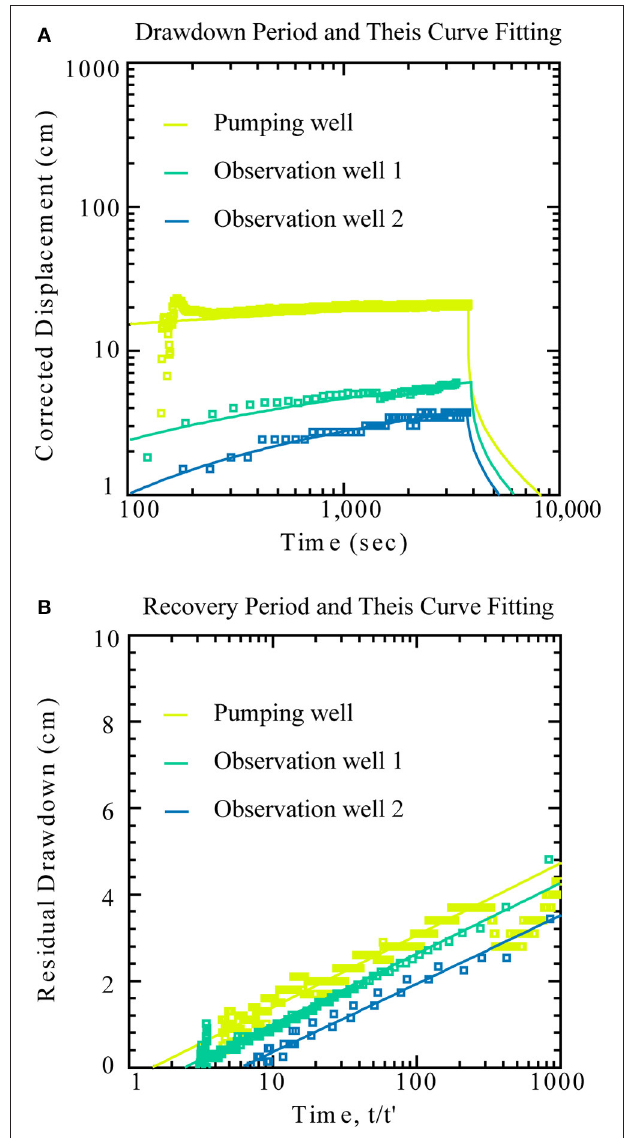
FIGURE 8 | Aquifer test curve fitting. (A) Recharge-corrected drawdown over time and Theis solution curves in the pumping and two observation wells during the second aquifer test at FA16_6. The squares represent water level displacement from the water level prior to pumping in different wells. The lines represent the Theis solution to the drawdown data. (B) Residual drawdown vs. time elapsed since the start of pumping relative to the time since pumping stopped (t/t ′ ) and the Theis solution curves for aquifer test 1 at FA16_6 and FA16_6 The squares represent water level measurements after pumping stops and the lines represent the Theis solution to the recovery data.